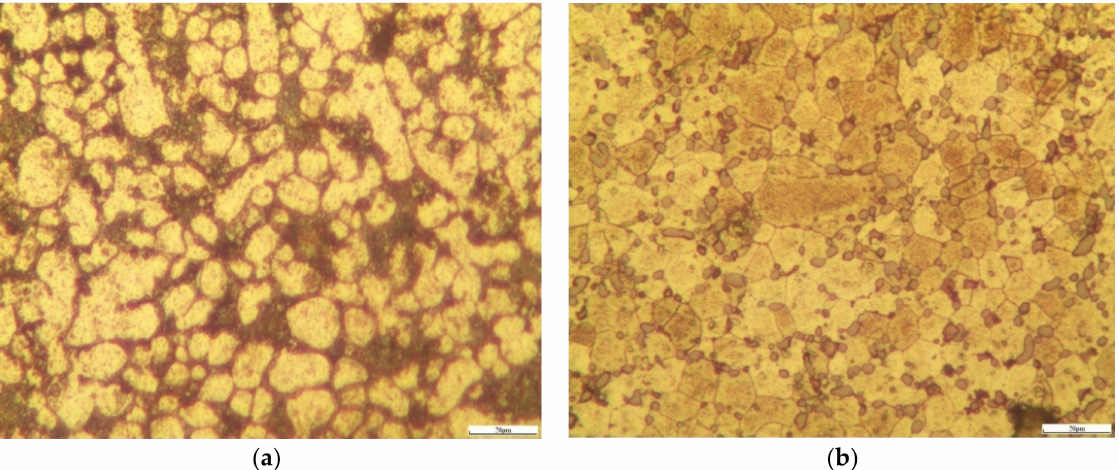
Figure 3. Metallographic structure of a non-heat-treated, die-cast sample: ( a ) before heat treating; ( b ) after heat